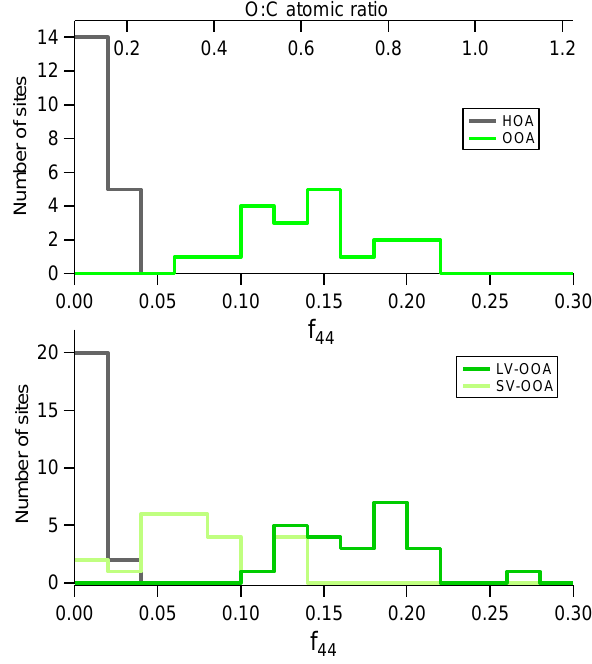
Fig. 2. Histograms showing the distribution of f 44 and estimated O:C atomic ratios observed across the multiple sites. The top panel corresponds to sites where only one OOA component is obtained. The bottom panel corresponds to sites where both LV-OOA and SV- OOA are